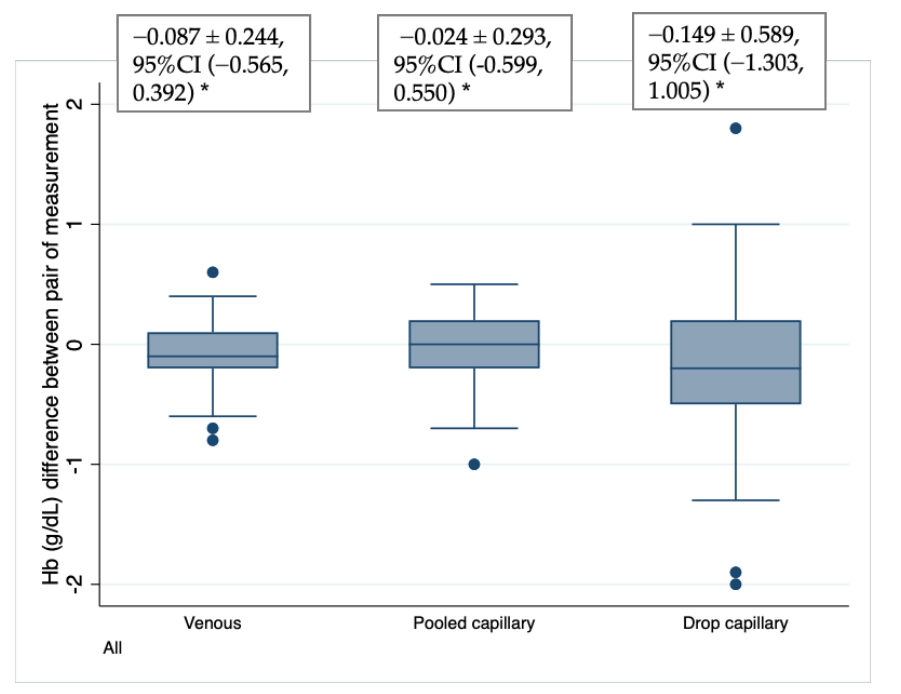
Figure 3. Box plots of Hb difference * (g/dL) between measurement duplicate analyzed using the HemoCue 201+. * Bland–Altman Mean ± SD; (95%CI).